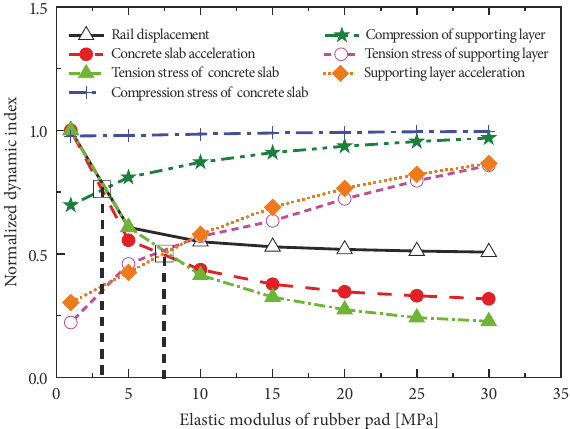
Figure 9. Influence of elastic modulus of rubber pad on dynamic response of the slab